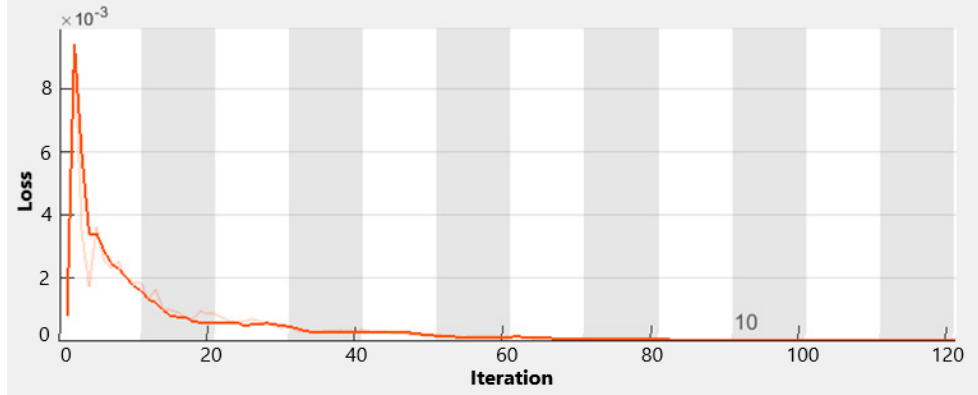
Figure 7. Root-mean-square error (RMSE) performance of the proposed LSTM network during the training phase.